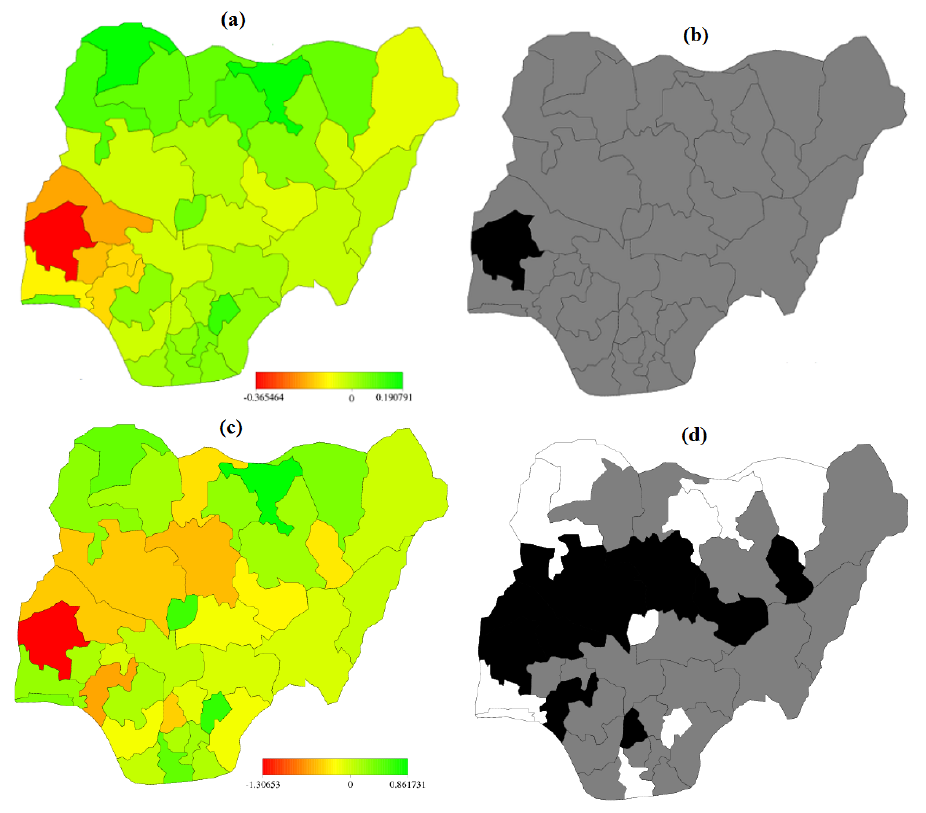
Figure 4. Spatial effects of ( a ) posterior mode and ( b ) 95% credible intervals of model B.1 ( c ) posterior mode and ( d ) 95% credible intervals of Model B.3 for cumulative multinomial